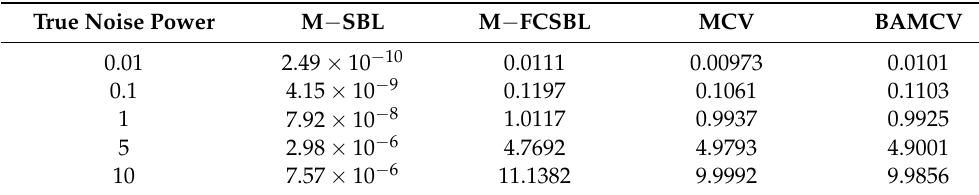
Table 4. Noise power